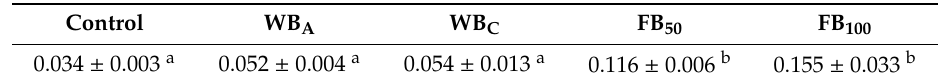
Table 1. The content of ascorbic acid (mg · g − 1 FW) in extracts from white cabbage after predation by cabbage butterfly larvae or flea